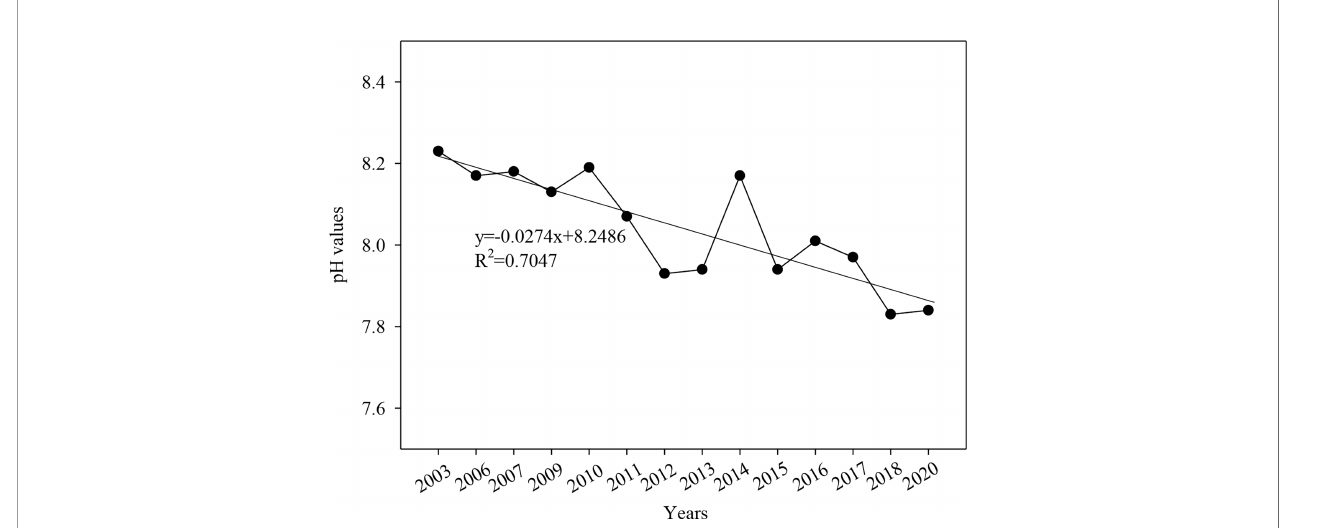
FIGURE 3 | Variations of pH values during the rainy seasons for the past 20 years. Data obtained from the Marine Environmental Monitoring Centre of Beihai, State Oceanic